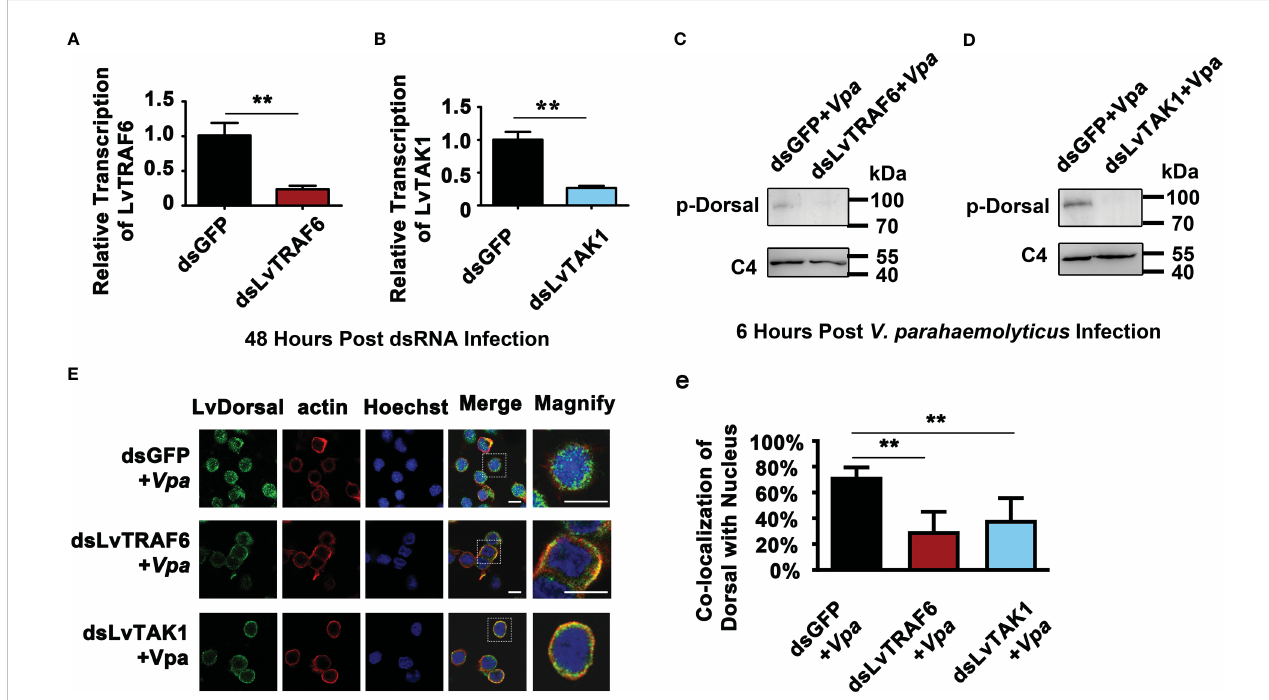
FIGURE 7 Roles of LvTRAF6-LvTAB2-LvTAK1 complex in regulating LvDorsal-L activation during V. parahemolyticus infection. (A-B) The RNA interference ef fi ciencies of dsRNA-LvTRAF6 (A) and dsRNA-LvTAK1 (B) were examined by qPCR. The hemocytes from 3 shrimp per group were sampled for QPCR. (C-D) Phosphorylation of LvDorsal-L after dsRNA-LvTRAF6 (C) and dsRNA-LvTAK1 (D) injection following with V. parahaemolyticus infection were analyzed by western blotting with anti-p-LvDorsal antibody. Hemocytes from nine shrimp per group were sampled for western blotting. (E) LvDorsal subcellular location in hemocytes in response to dsRNA-LvTRAF6 and dsRNA-TAK1 during V. parahaemolyticus infection. The scale bar = 5 m m. (e) Co- localization of LvDorsal and Hochest-stained nucleus in hemocytes was calculated by WCIF ImageJ software and analyzed statistically by student ’ s T test (** p < 0.01). Hemocytes from three shrimp per group were sampled for immuno fl